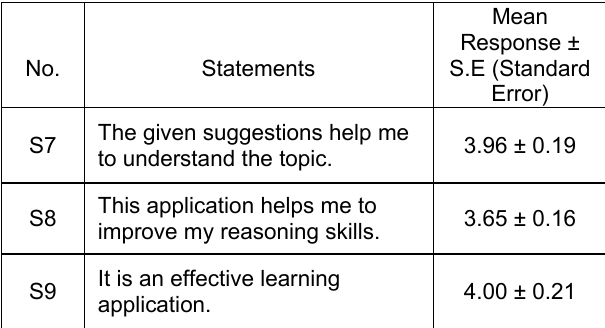
Table 4. Responses related to